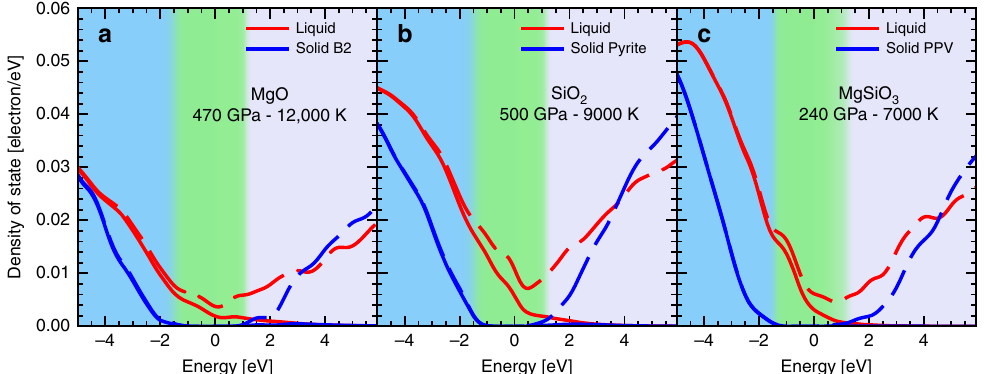
Fig. 2 Electronic density of states (DOS) of silicates. The liquid (red) and the solid (blue) DOSs with the Fermi level shifted to 0 eV are plotted for a MgO, b SiO 2 , and c MgSiO 3 . The dash-dotted lines are the complete DOSs and the full the occupied DOSs only. The conditions were chosen so that they are close to the respective Hugoniot curve 26,33,34 and the expected phase boundary 20,27,33 as shown by the blue stars in Fig. 1. The blue shaded region represents the valence band in the solid, the green one is the gap, and the light purple one is the conduction band